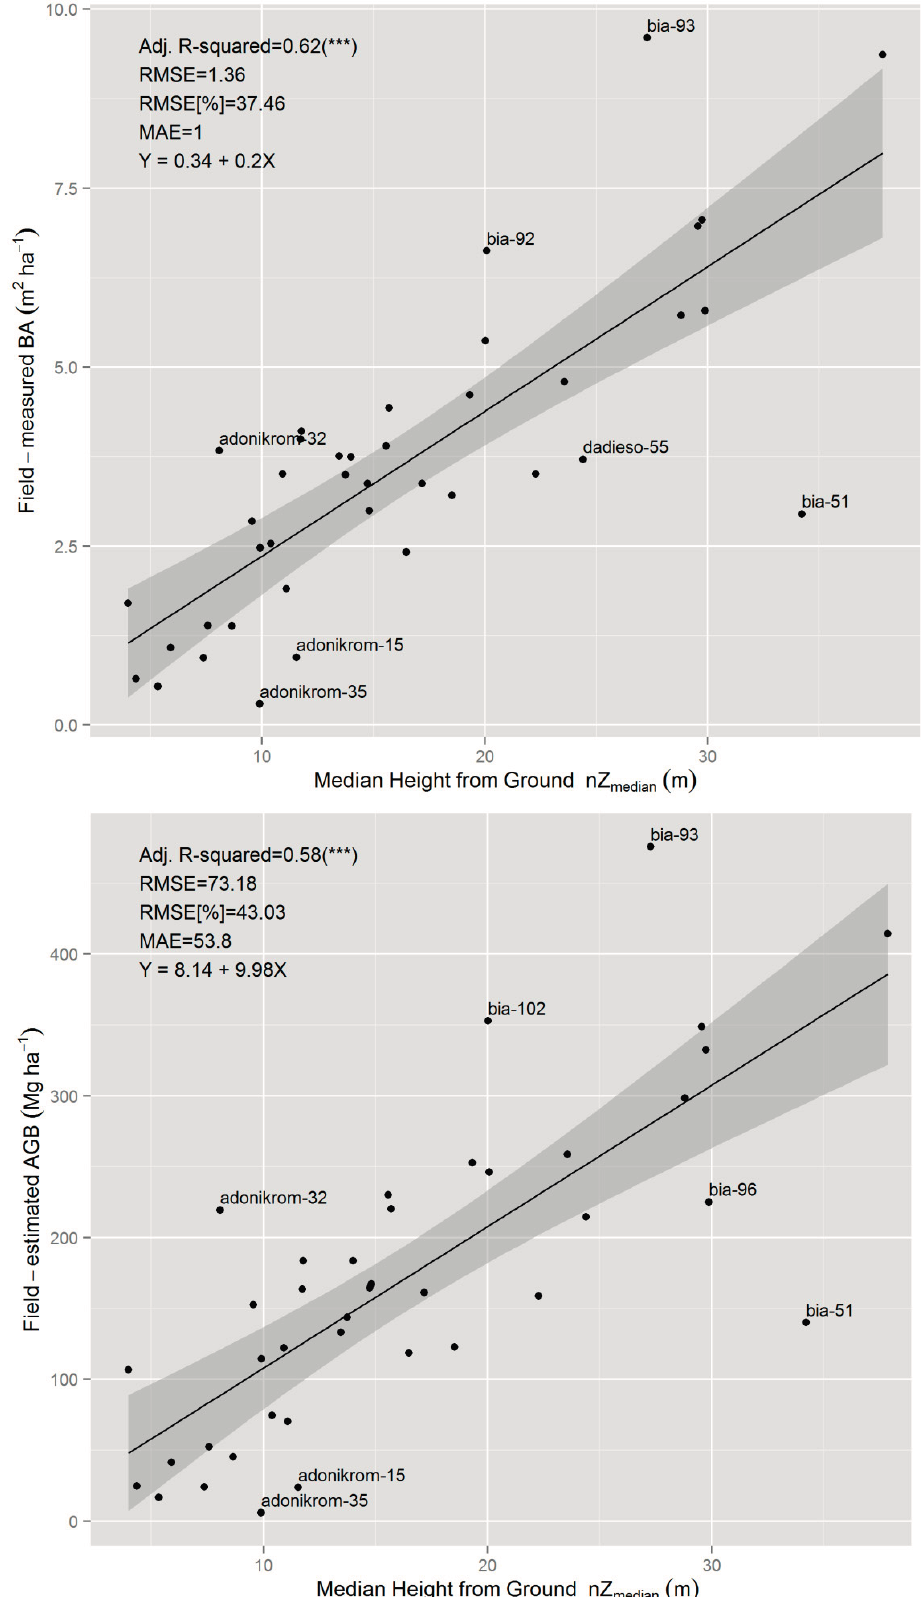
Figure 5. Basal area ( top ) and aboveground biomass ( bottom ) modelled by the median height above ground (nZ ) *** p -value < 0.001. Bands represent the 95% median confidence